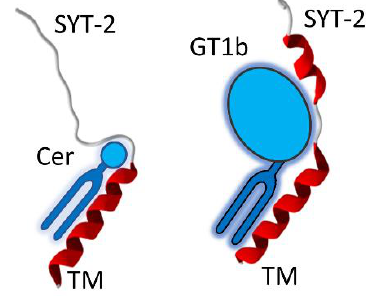
Figure 8. Lipid chaperone effect as a major parameter of the EDPS paradigm. The extracellular domain of synaptotagmin-2 (h-SYT2) is totally disordered when bound to ceramide (Cer), whereas it acquires a α -helix structure when bound to ganglioside GT1b. Both models were obtained with Hyperchem and submitted to energy minimization with the Polak – Ribière algorithm according to the protocol used for BoNT/A1-h-SV2C as described in Materials and Methods. Lipid molecular structures have been schematized for clarity. The global shape and volume of these lipids are directly responsible for these typical chaperone effects. This mechanism accounts for the critical role played by raft lipids on protein structure, illustrating the EDPS paradigm. TM, transmembrane domain.